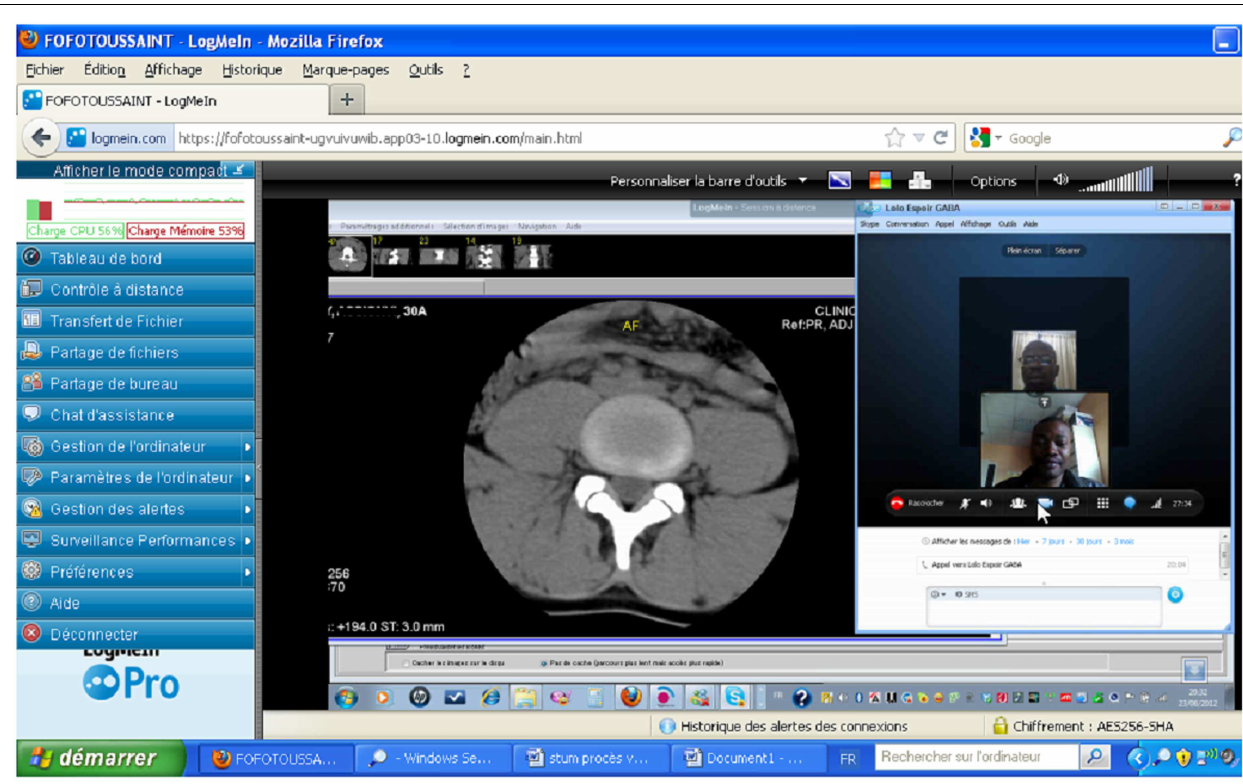
FIGURE 3 |Tele-radiology screen capture (vertebral CT scan interpreted remotely using LogMeIn)